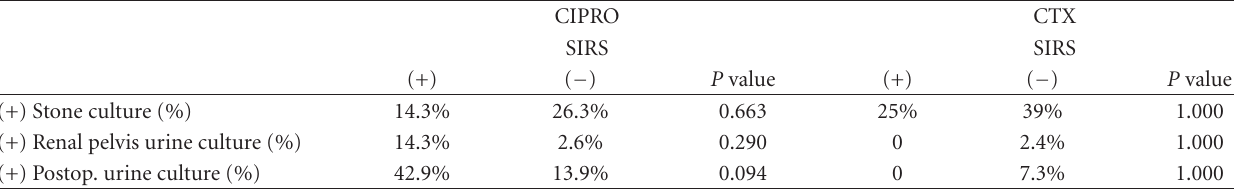
Table 3: E ff ect of culture positivity on SIRS between CIPRO and CTX groups.